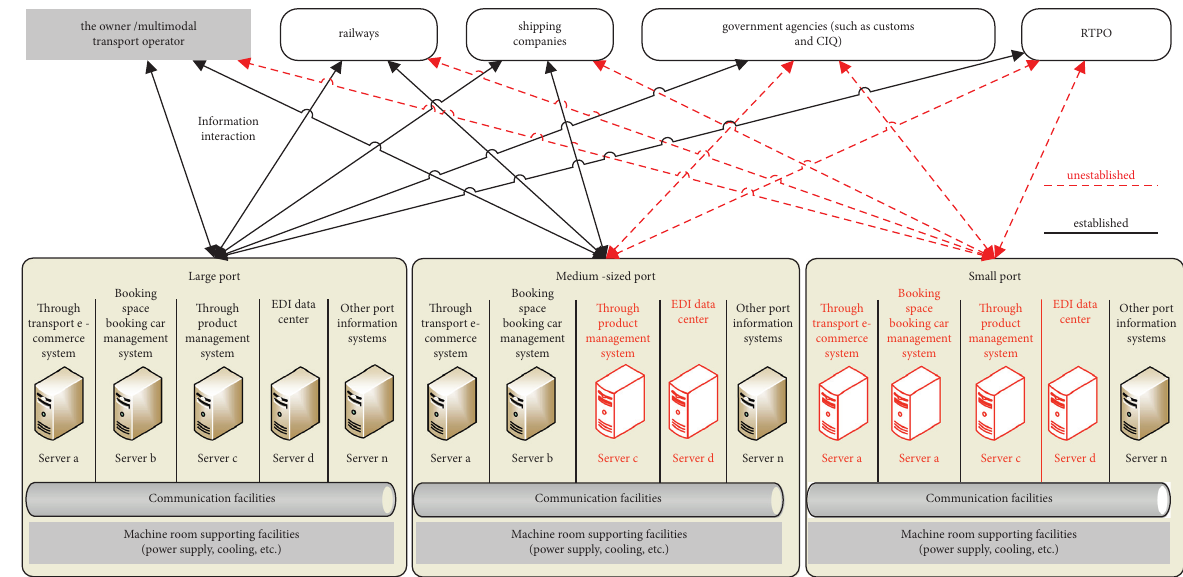
Figure 1: The port-centered information model of railway-river combined